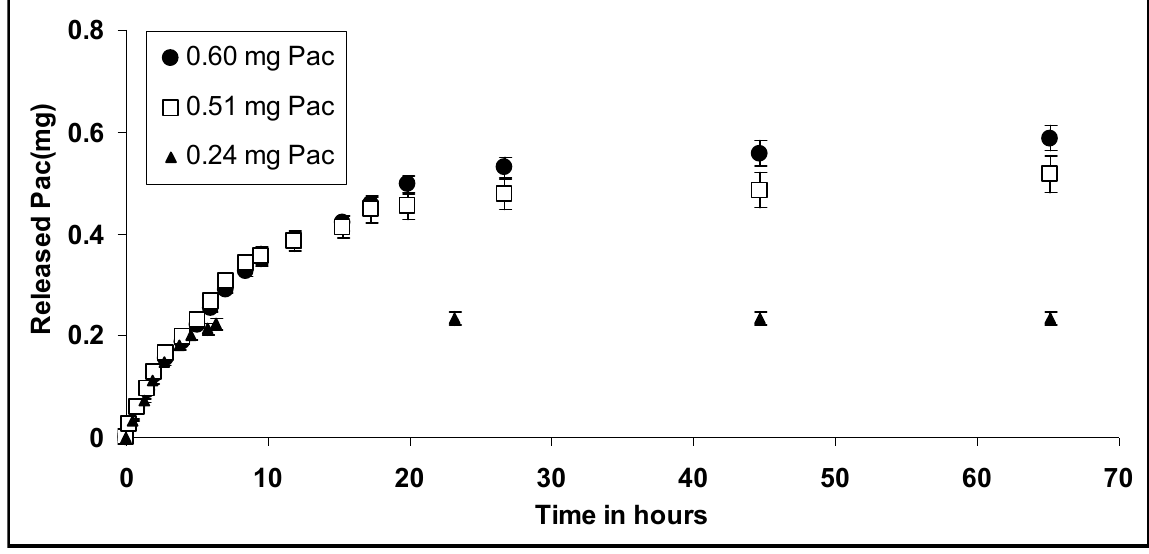
Figure 7. Cumulated release profile of physically incorporated Pac from HA-coated CH- PEO membranes in phosphate-buffered ethanol:water (40:60 v/v) solution. The solvent was exchanged regularly to maintain sink conditions. Three different amounts of Pac (0.24, 0.51 and 0.60 mg) were incorporated